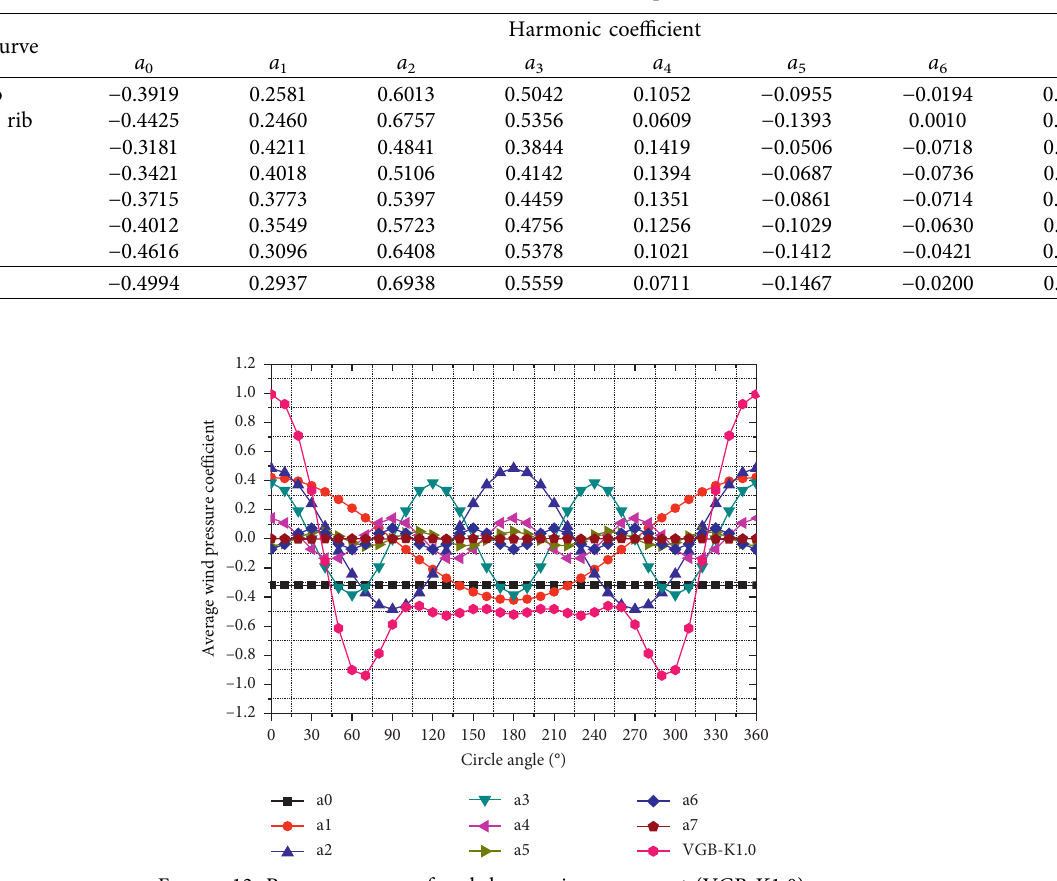
Figure 12: Wind pressure coefficient in China and German codes. Table 3: The Fourier coefficients of each harmonic of specification curves.